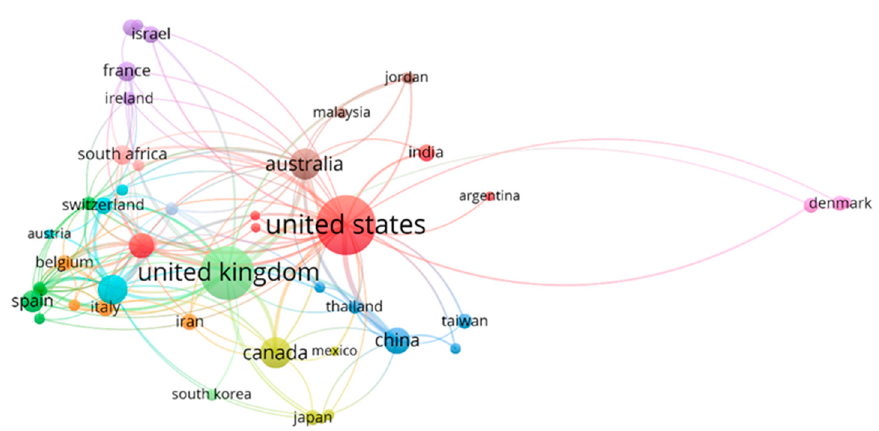
Figure 5. Network of cooperation based co-authorship between countries. The United States led the red cluster, representing a robust collaborative link with Argentina, Ethiopia, India, the Netherlands, and the Philippines. Spain heads the dark green group, and its major collaborating countries are all from the European continent (Bulgaria, Greece, Hungary, Norway, and Poland). China fronted the blue cluster, whose collaborators are from the same continent: Bangladesh, Hong Kong, Taiwan, and Thailand. For its part, the yellow cluster has representatives from the American continent (Canada and Mexico), Asia (Indonesia and Japan) and Africa (Nigeria). The dark purple group represents co-authorship from Brazil, France, Ireland, Israel, and Portugal.